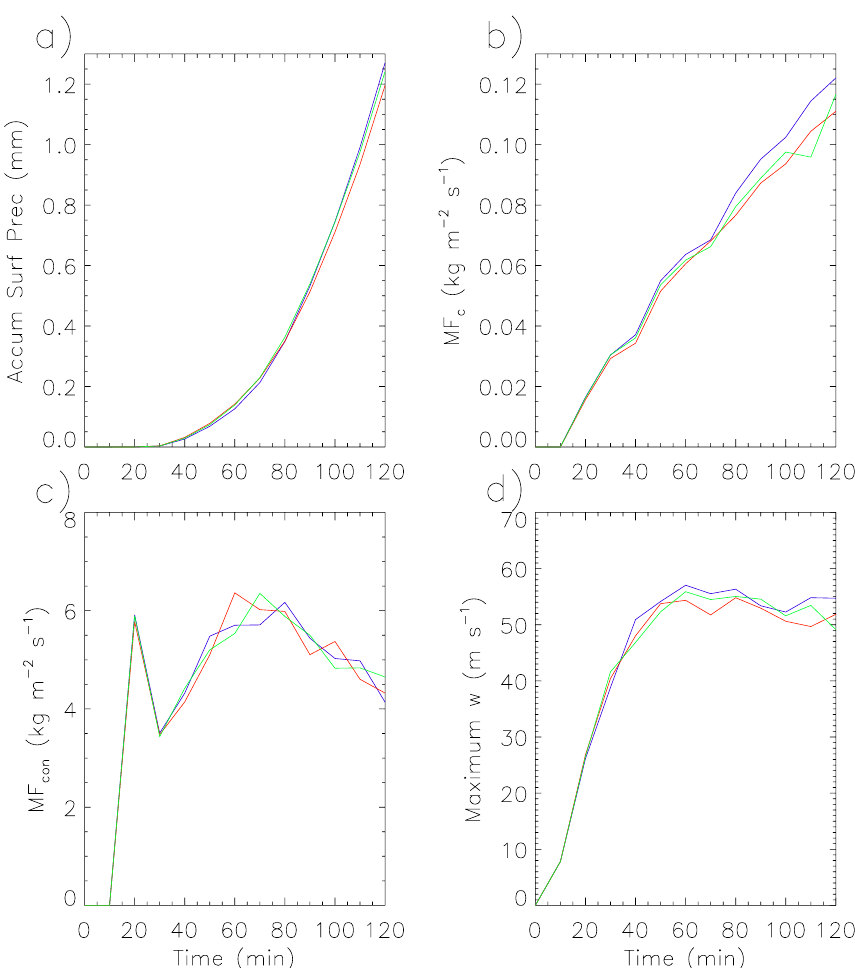
Fig. 3. Timeseries of (a) domain-mean accumulated surface precipitation, (b) domain-mean convective mass flux, MF c , (c) convective mass flux averaged only within convective cores, MF con , and (d) domain-maximum vertical velocity, w, for the baseline model configuration (BASE). Results for pristine, moderately polluted, and highly polluted conditions are shown by blue, green, and red lines, respectively. Results for MF c and MF con at a height of 8.25km are